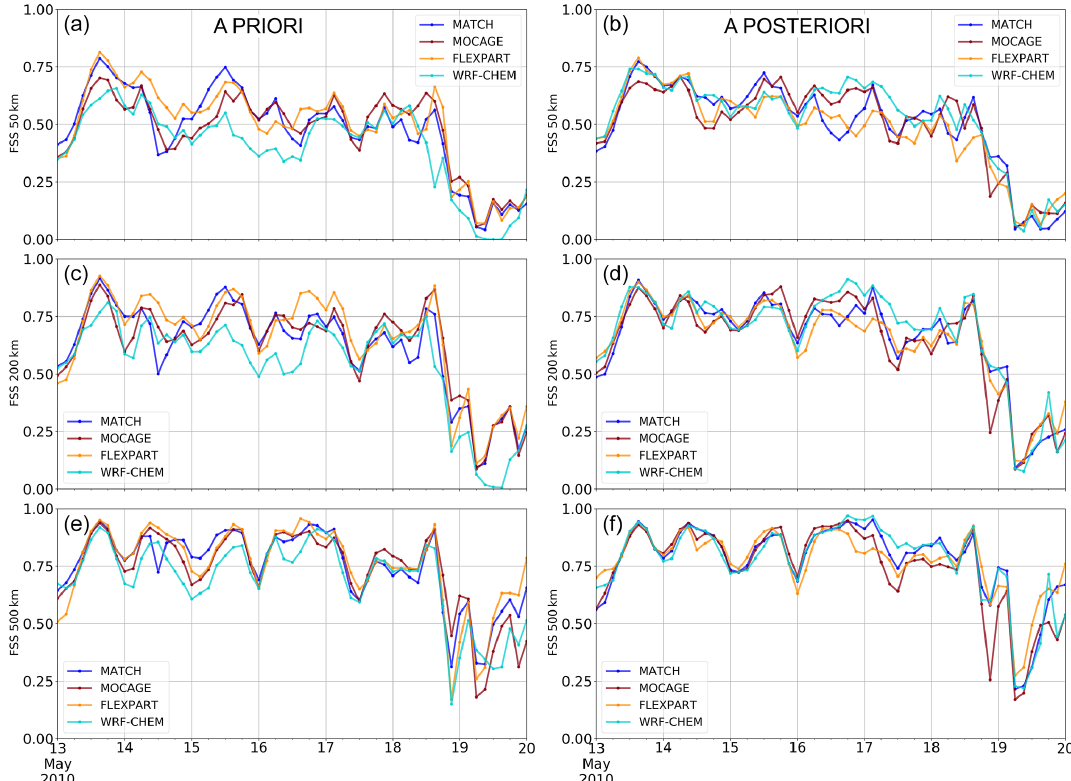
Figure 4. Comparison of the fraction skill score (FSS) for ash location, for the four models with their a priori source terms (a, c, e) and with the a posteriori source term (b, d, f) . The FSS values are shown for radii of 50 (a, b) , 200 (c, d) , and 500km (e, f)